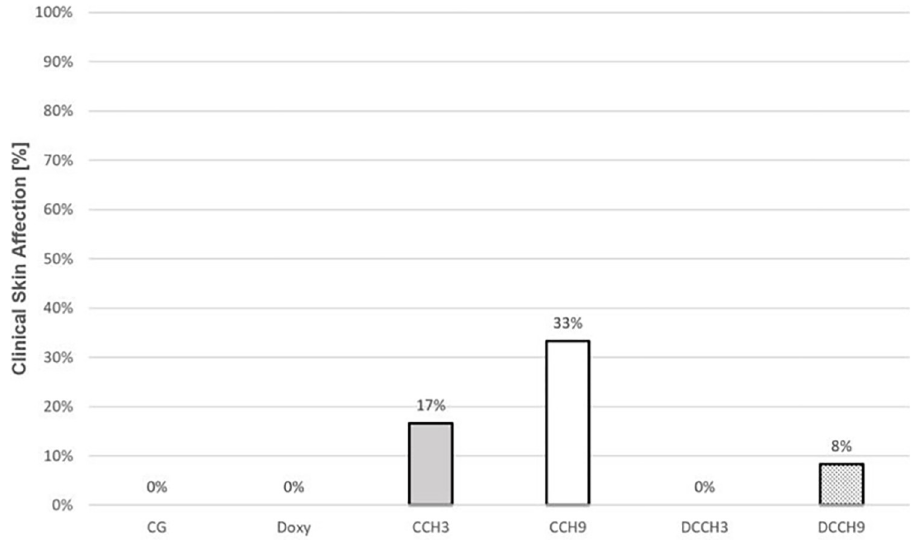
Fig 4. Results for clinical skin evaluation. Skin affection rates shown in % of the whole study groups (n = 12).